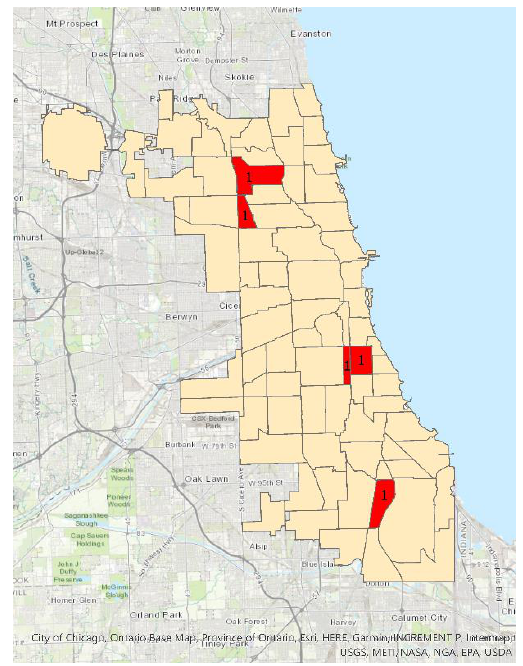
Figure 10. High value clusters by weekday at community level